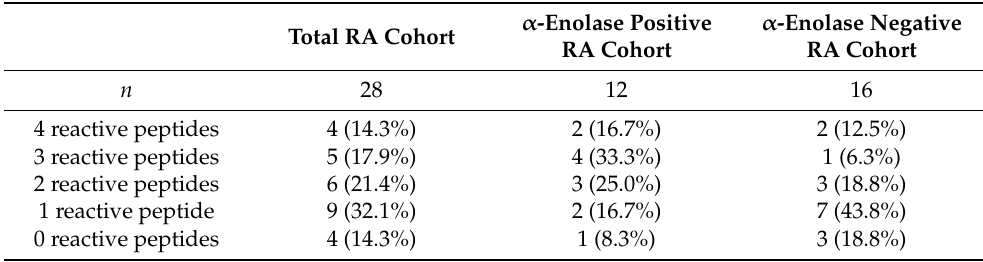
Table 2. Reactivities of the RA cohort to citrullinated peptides originating from pro-filaggrin, proteoglycan, fibronectin and EBNA-2.